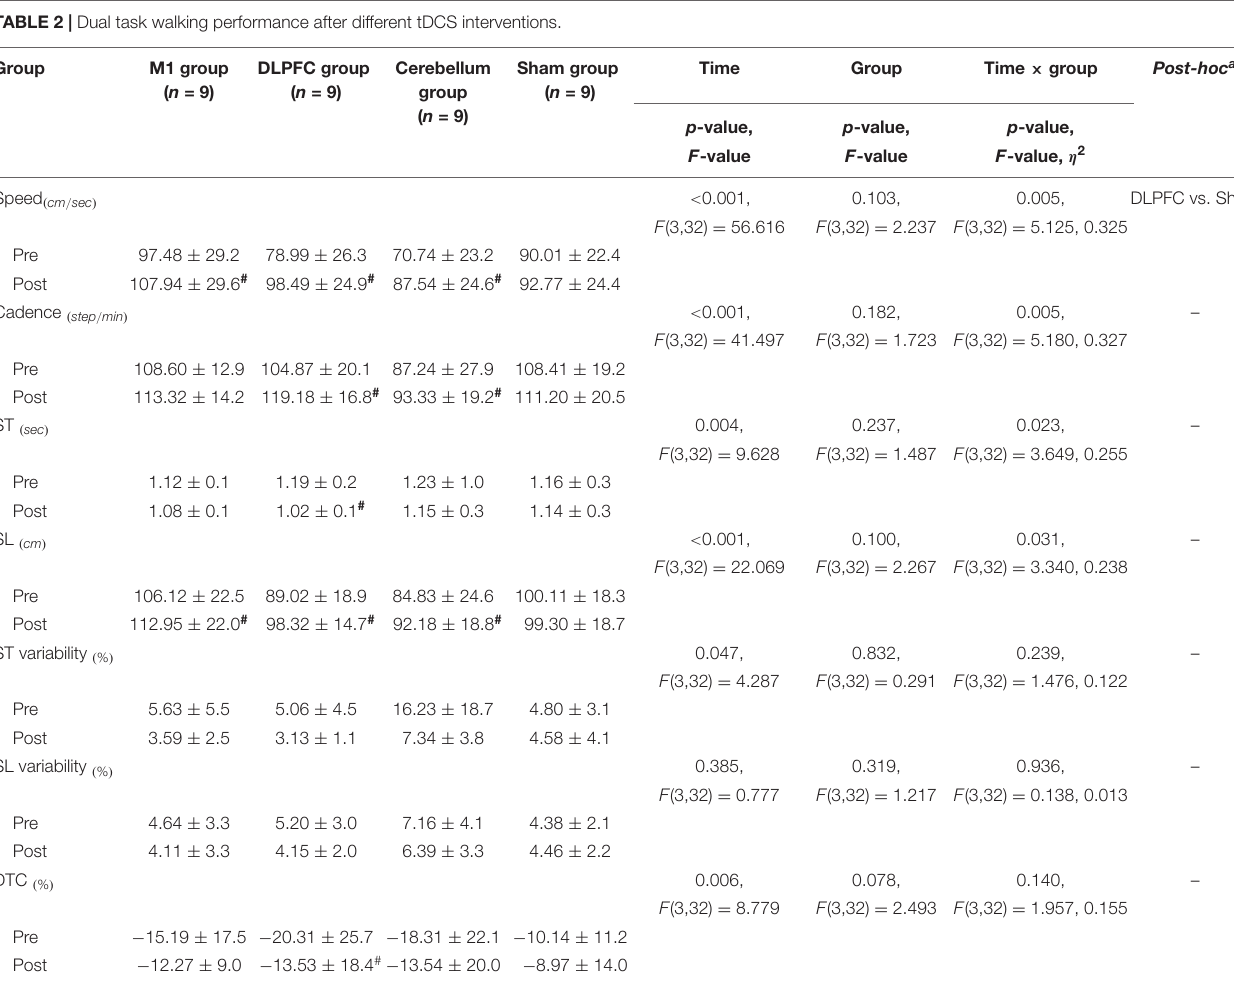
TABLE 2 | Dual task walking performance after different tDCS